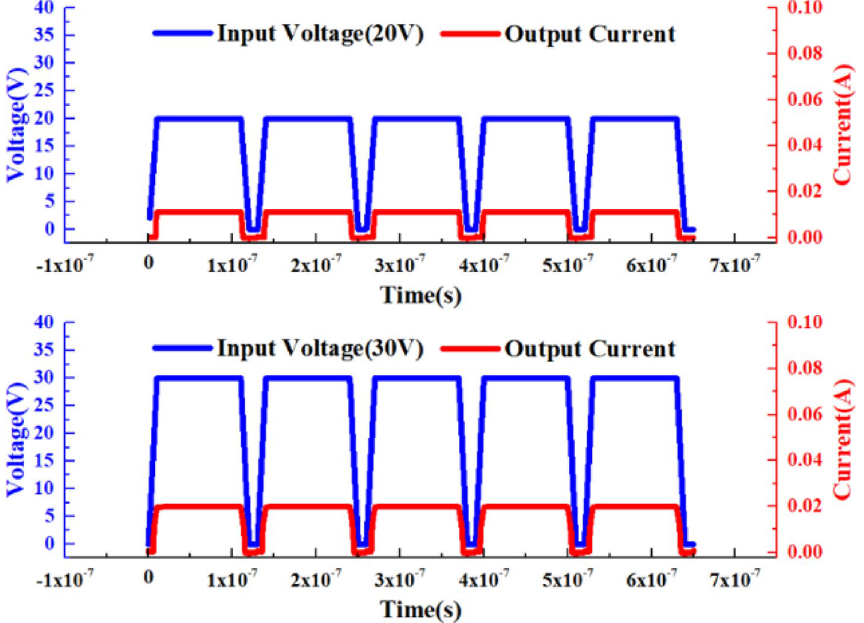
Figure 4. Simulation voltage–time curve and simulation current–time curve of VADTS under the excitation of square wave signal (20 V, 30 V).